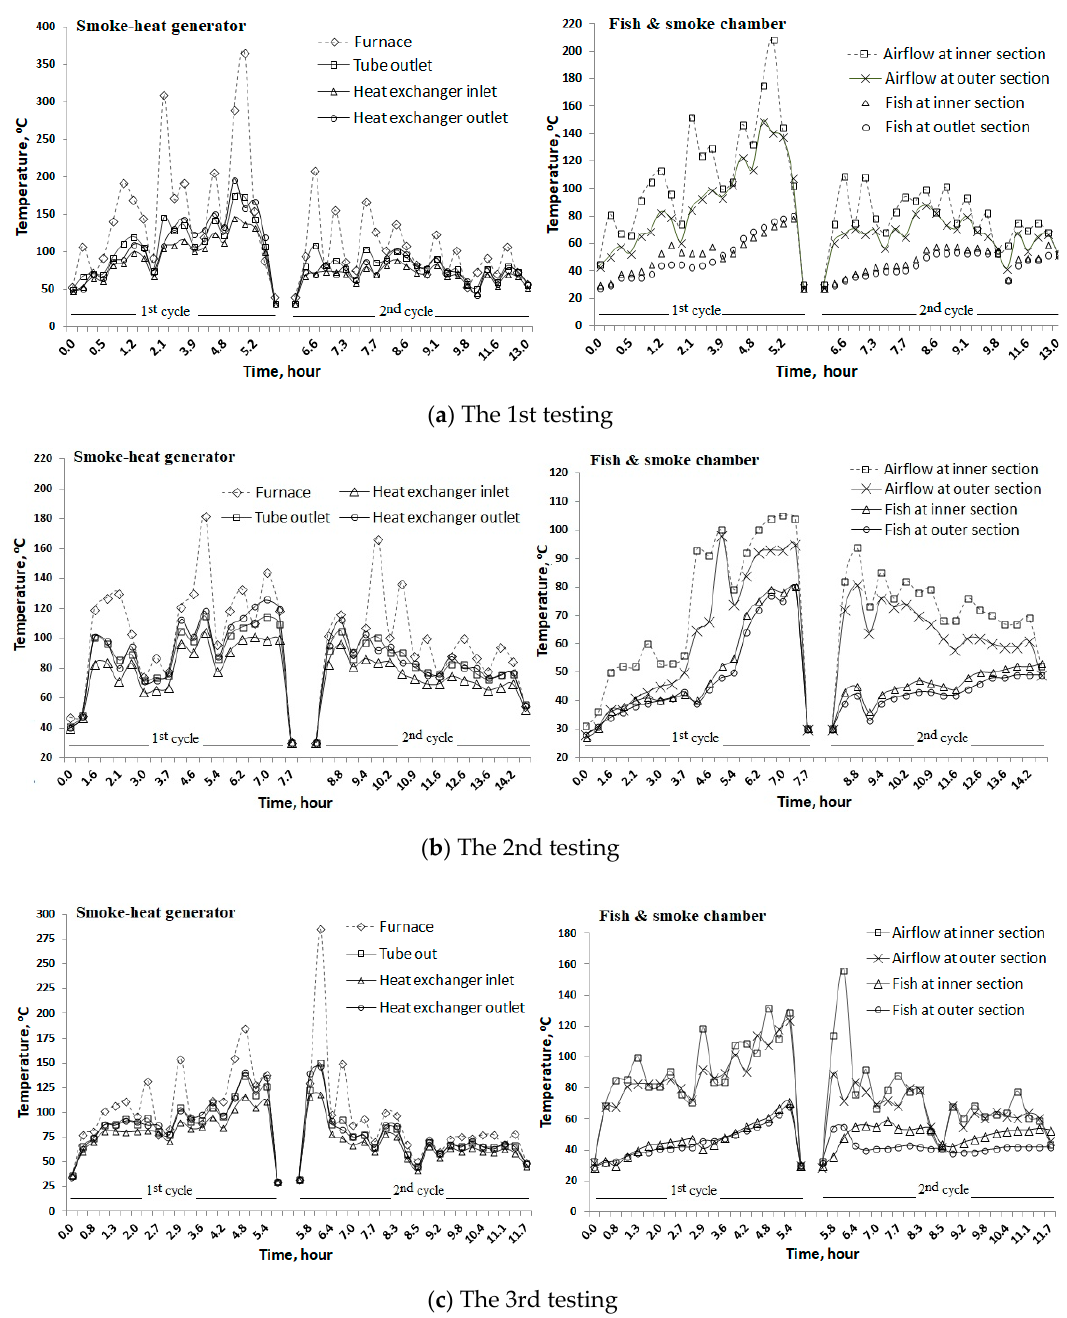
Figure 4. The temperature profile of the ( a ) 1st, ( b ) 2nd, ( c ) 3rd test of fish smoking.